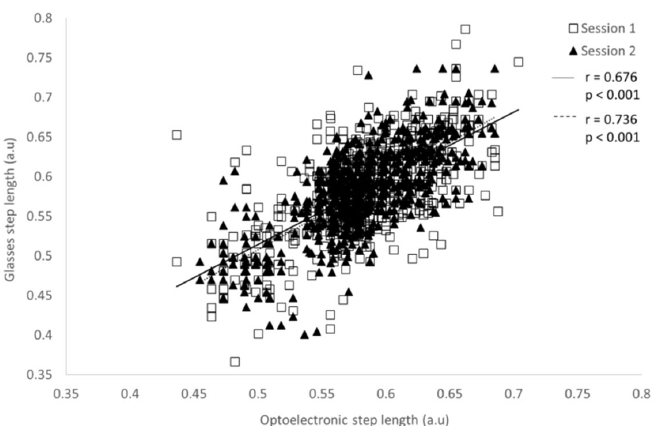
Figure 5. Pearson’s correlation of the step length normalized by the lower limb length measured with the optoelectronic system and the glasses during 30 s of gait at 0.90 m/s without a cervical collar for both test sessions.